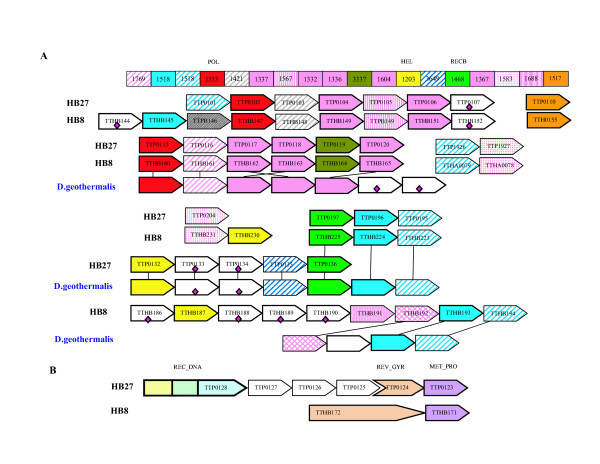
A. Organization of genes encoding the putative thermophyle-specific DNA repair system in two Thermus strains and the draft genome of D. geothermalis. The boxes on top of the figure show COG numbers. Genes are shown by block arrows indicating the direction of transcription and identified by their systematic names. For each column of the alignment, the corresponding COG number and predicted function is indicated. D. geothermalis' genes are connected with respective orthologs in both TT strains by a straight line. Generally, orthologous genes are shown by the same color and pattern. The exceptions are the RAMP proteins of COGs 1336, 1367, 1604, 1337 and 1332, which are all shown in pink. Other, more distant RAMPs are also shown in pink, with different patterns [16]. Proteins that do not belong to COGs but have homologs in other species are marked by diamonds. Abbreviations: HEL, predicted helicase, HD nuclease – HD conserved motif containing predicted nuclease conserved region; POL – novel predicted polymerase, RECB – predicted nuclease of RecB family; B. Comparison of gene organization in the region of the megaplasmid coding for reverse gyrase in two TT strains. The shorter gyrase gene in HB27 indicates truncation. Abbreviations: REVGYR, reverse gyrase, MET_PR – predicted metal-dependent protease; REC_DNA – three-domain fusion protein (DnaQ endonuclease, DinG helicase, and RecQ helicase).